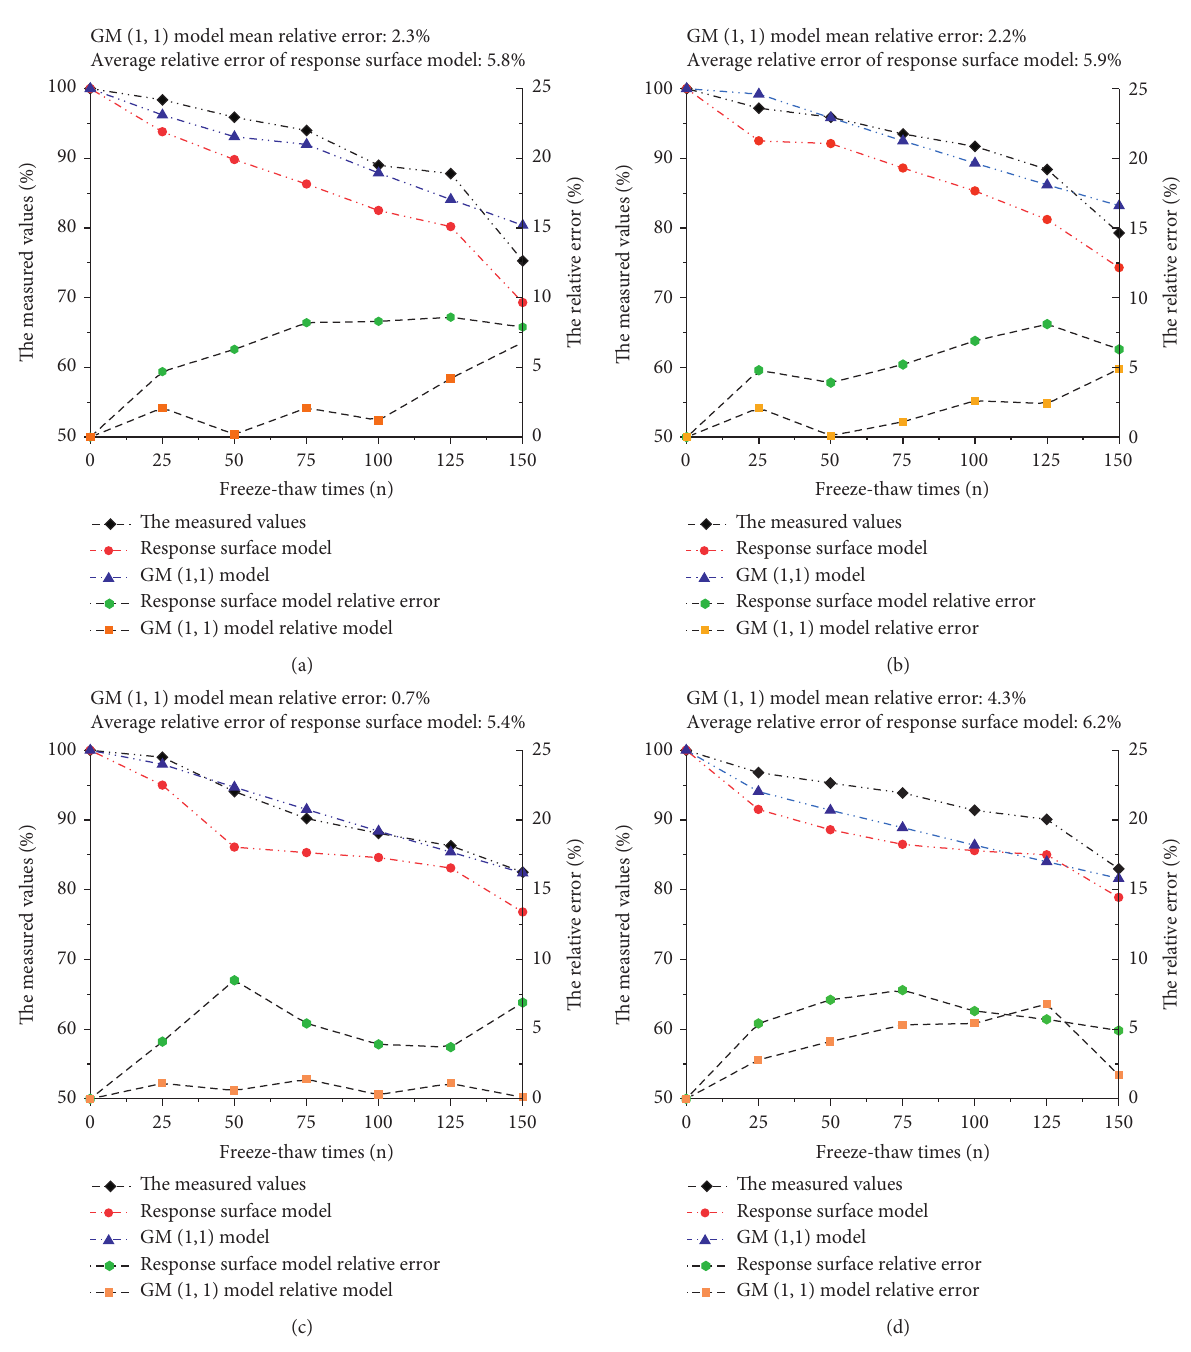
Figure 10: Accuracy comparison between GM (1,1) model and response surface model. (a) HDFC6-1. (b) HDFC9-1.5. (c) HDFC9-2. (d) HDFC12-2.